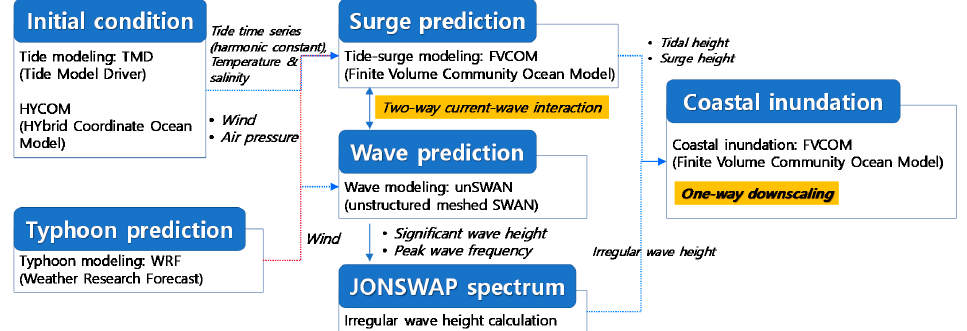
Figure 1. Conceptual diagram of analysis system and data processing .